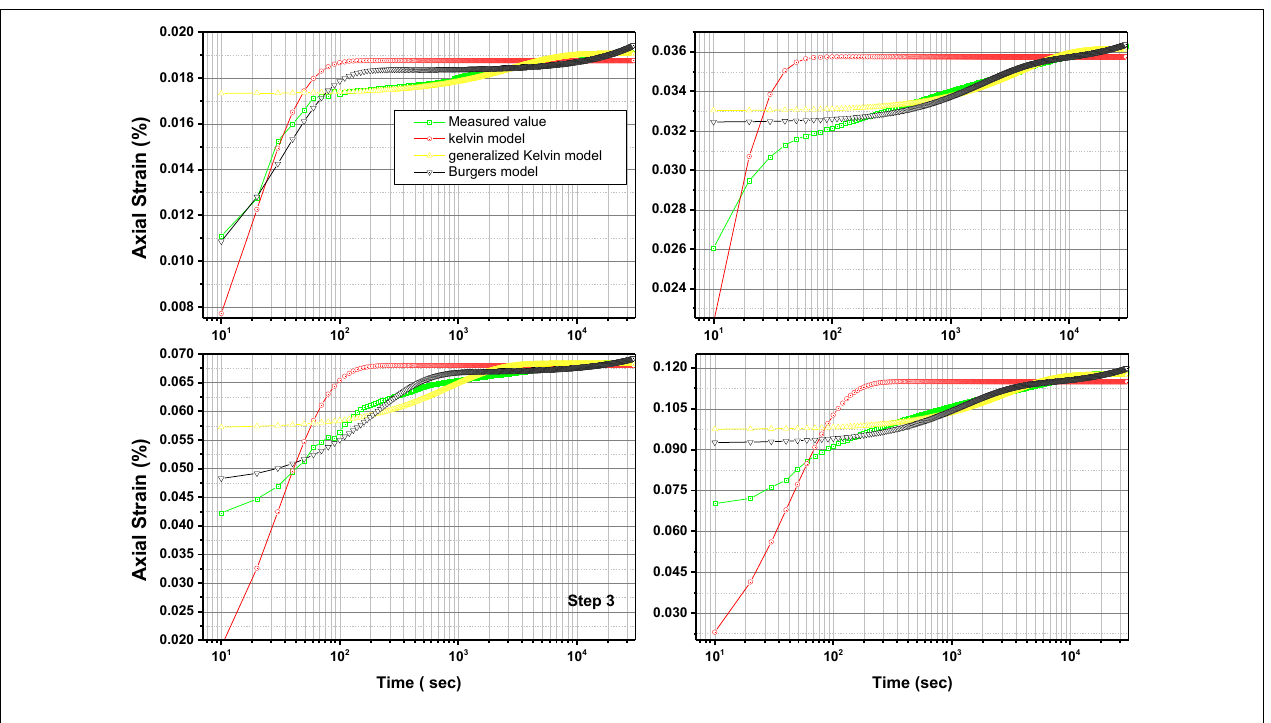
FIGURE 12 | Fitted curve for different creep models (time presented in log scale).